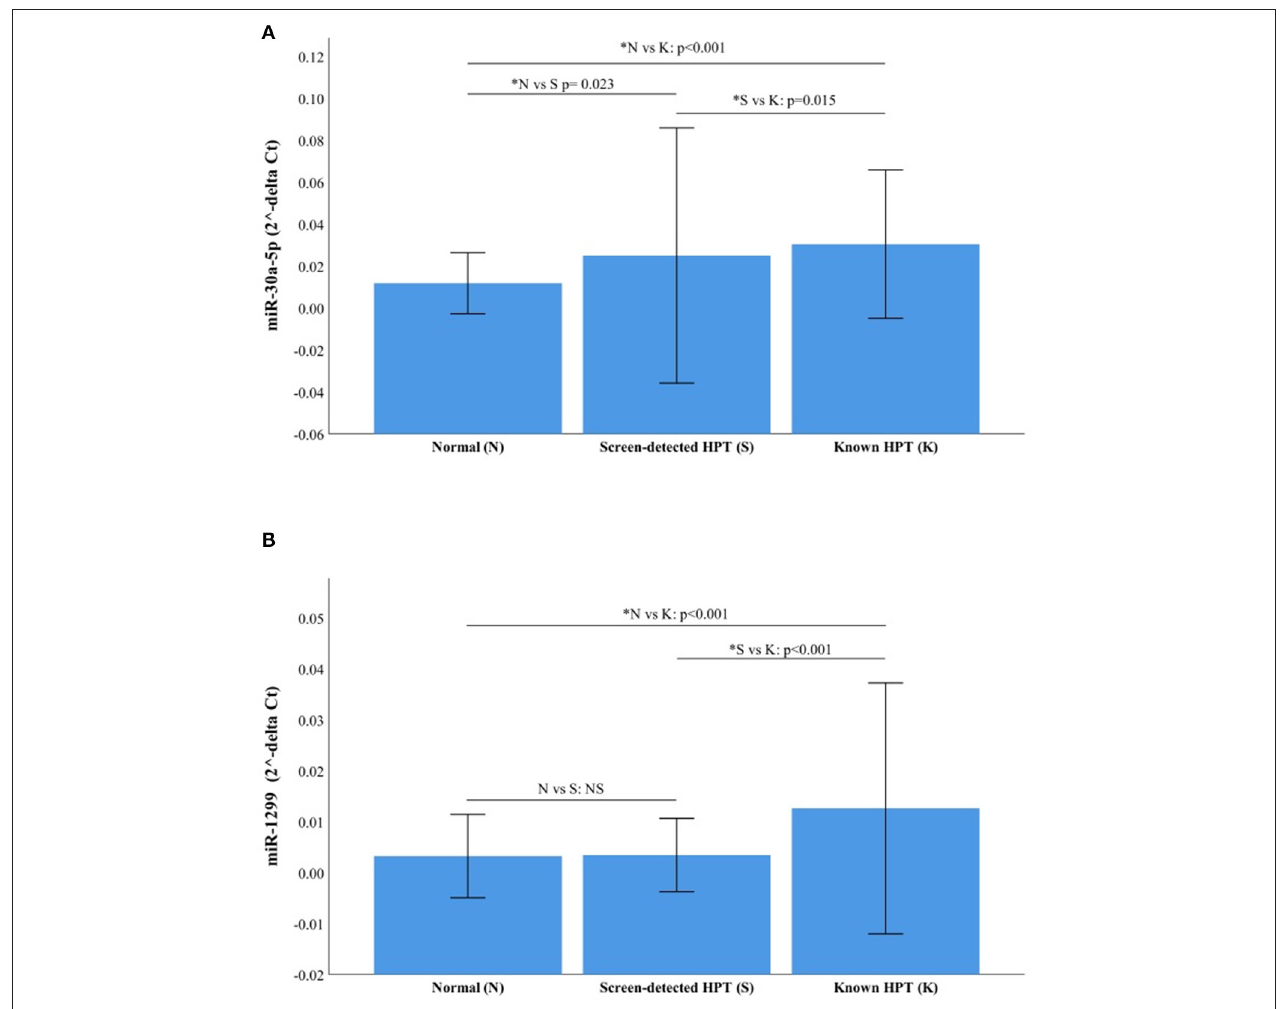
FIGURE 4 | Relative expression of miR-30a-5p and miR-1299. (A) miR-30a-5p in normotensive ( n = 116), screen-detected HPT ( n = 66) and known HPT ( n = 124). (B) miR-1299p in normotensive, screen-detected HPT and known HPT. Data are represented graphically as the mean ± SD. Not significant (NS) if p > 0.05 and significant p- value denoted by an